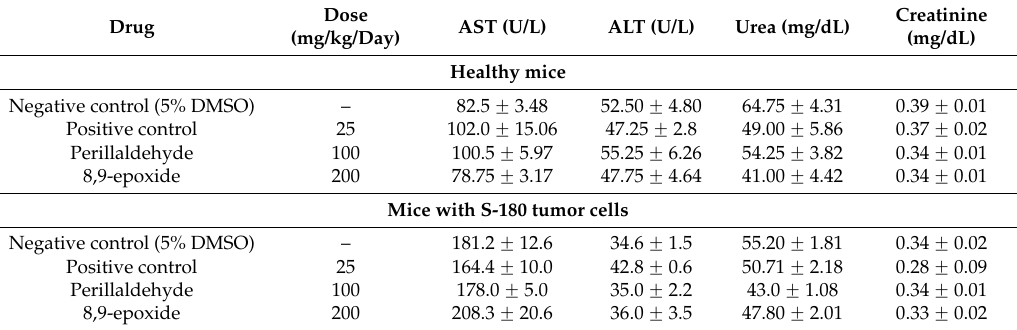
Table 2. The effect of perillaldehyde 8,9-epoxide on the biochemical parameters determined through blood of healthy animals and those inoculated with S-180 tumor